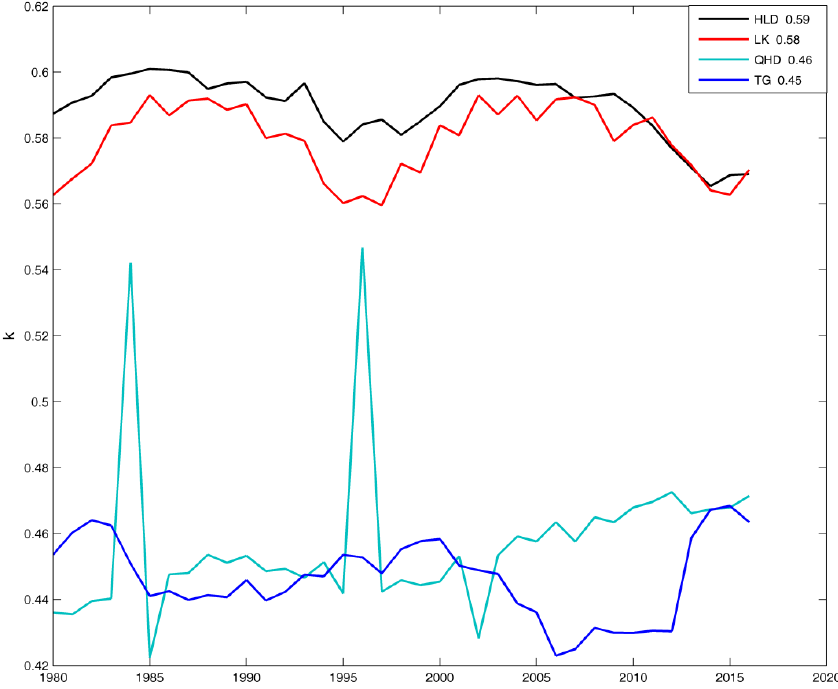
Figure 5. The annual k factor values ( y -axis) and the mean value (in the legend) at all four tide